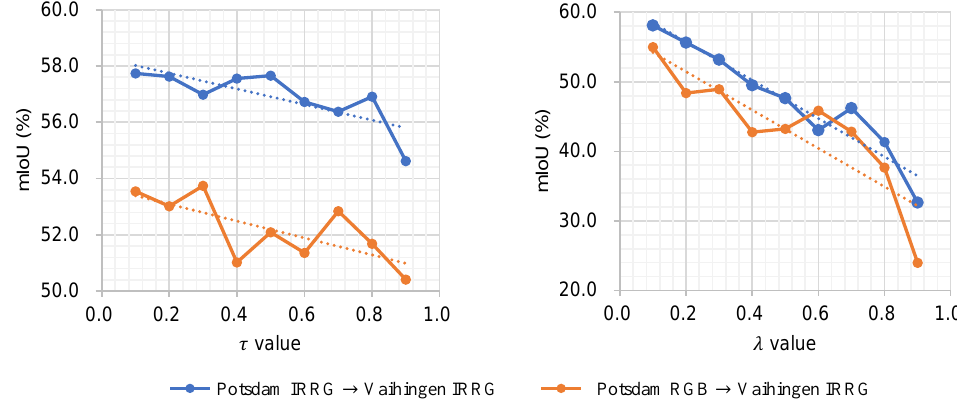
Figure 11. Ablation study of hyperparameter